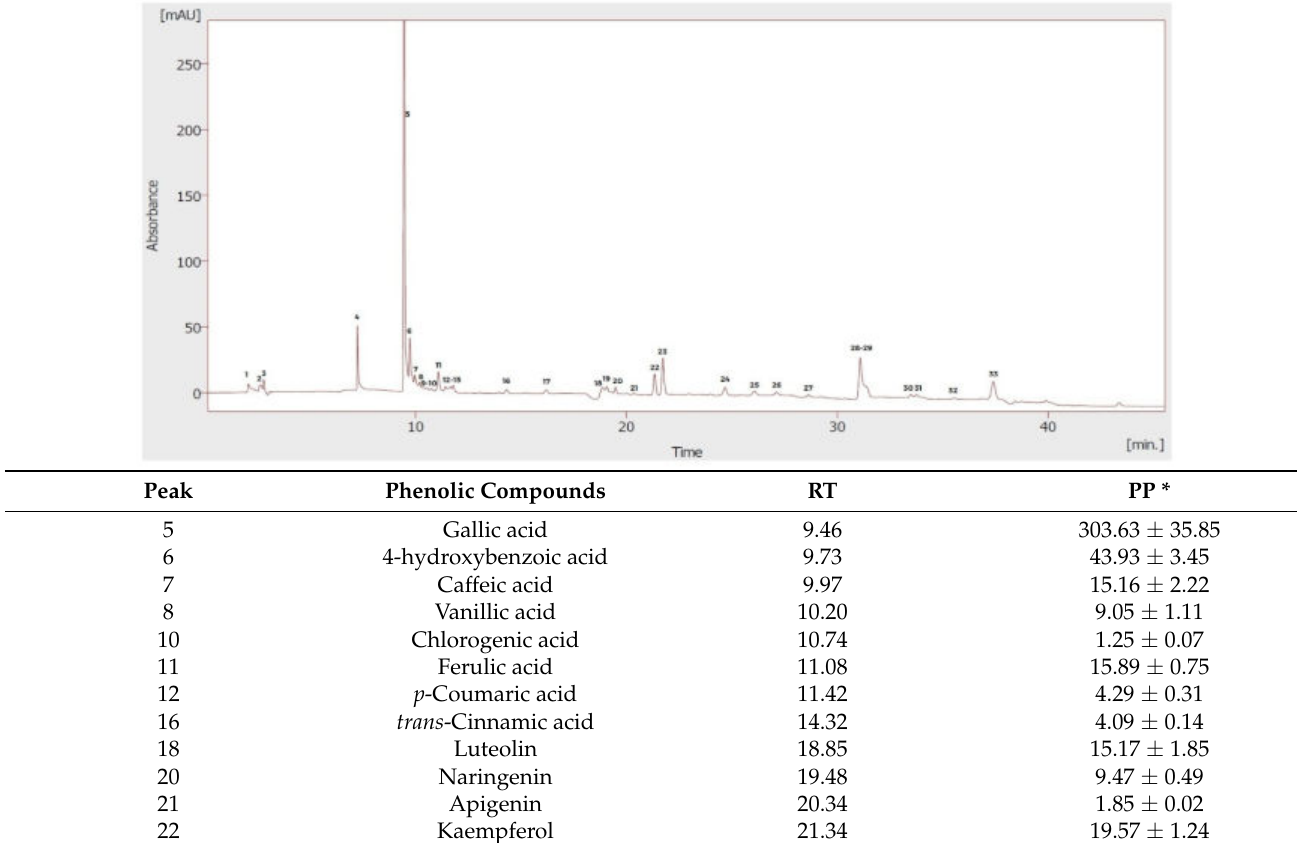
Table 2. The phenolic compounds identified in the extract of the fruit of P. peruviana